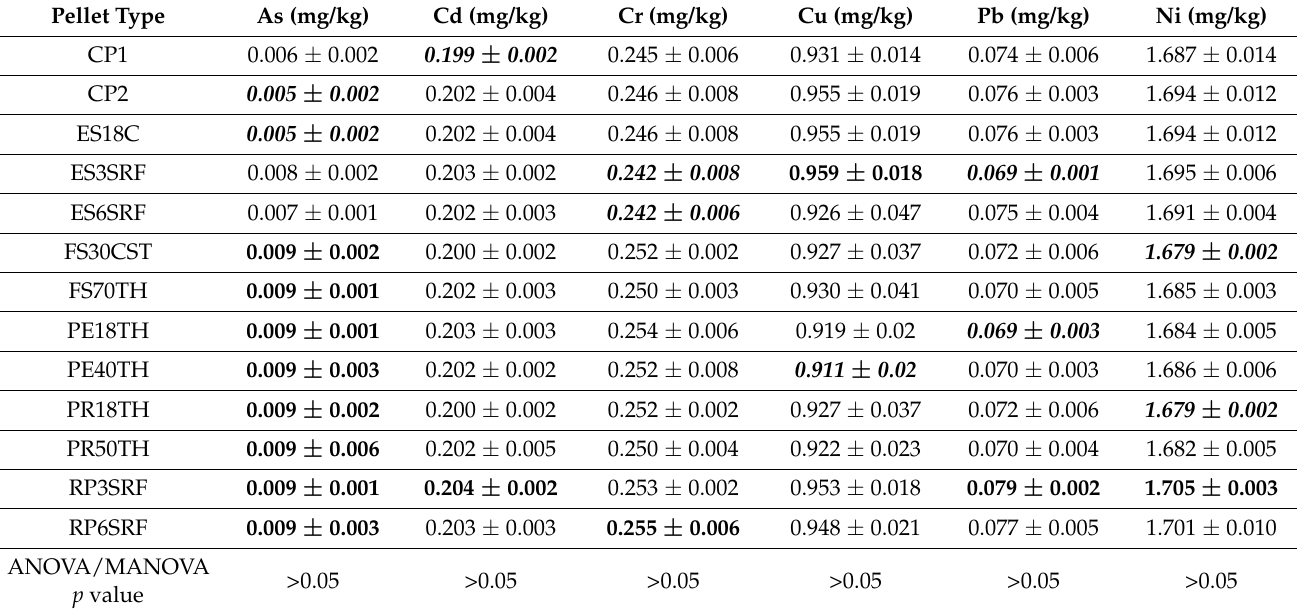
Table 5. Average ± standard deviation for chemical composition of various pellet types. The upper value is highlighted in Bold, the lower value in Bold-Italic.